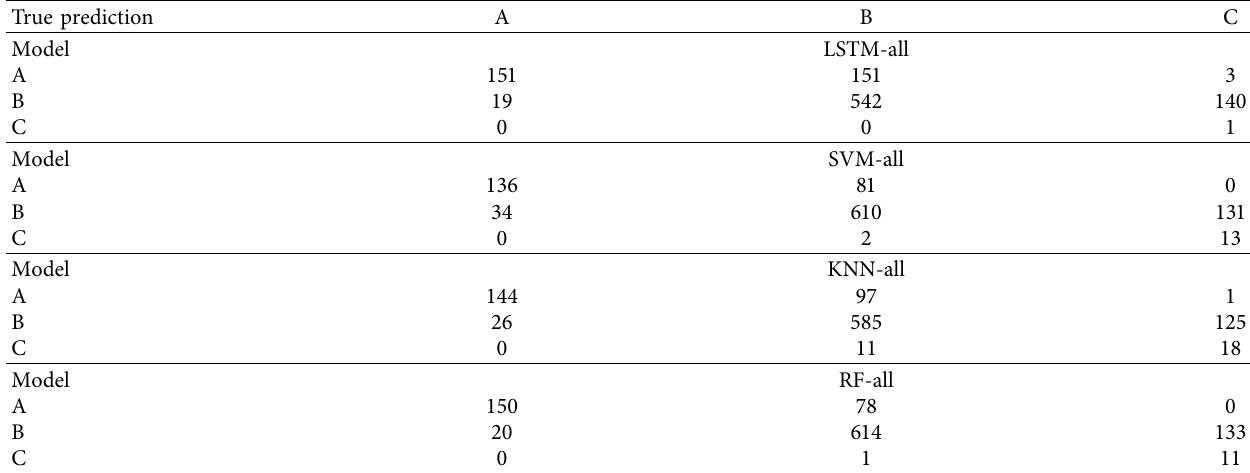
Table 7: Confusion matrices of predictions for the test dataset.